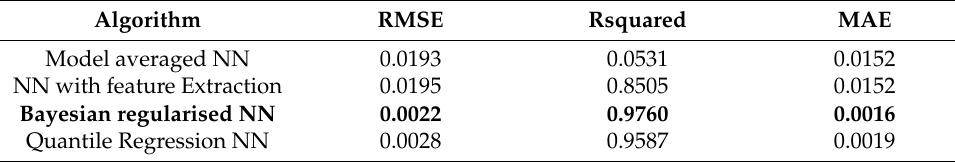
Table 5. Summary of trained neural networks.